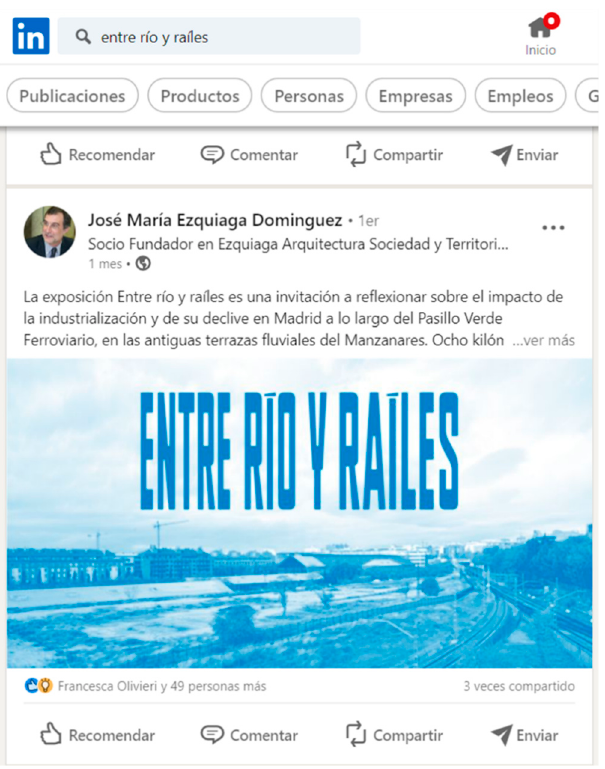
Figure 9. The exhibition “Between river and rails” announced and commented upon on LinkedIn by José María Ezquiaga, Head of Urban Planning of the Municipal Management in the 1980s and one of the first promoters of the PVF who today is an expert on urban